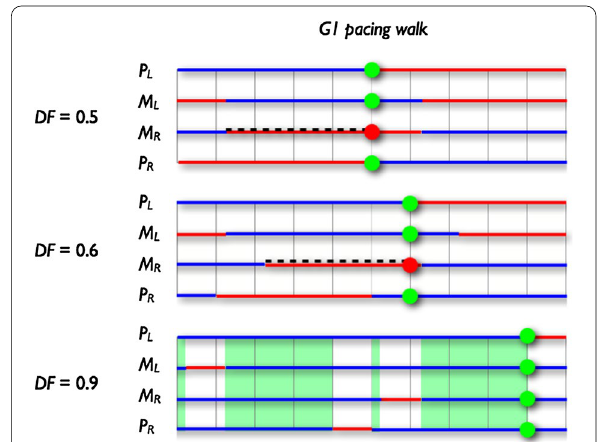
Fig. 15 The step cycle for a G1 ‘pacing walk’ for three different duty factors ( DF ). For DF 0.5 and 0.6 the right manus is in transition and = must have its position interpolated. For DF 0.625 all four limbs are in ≥ ground contact. As in Fig. 13, the dashed black line indicates α-phase φ α the relative phase between M R and P